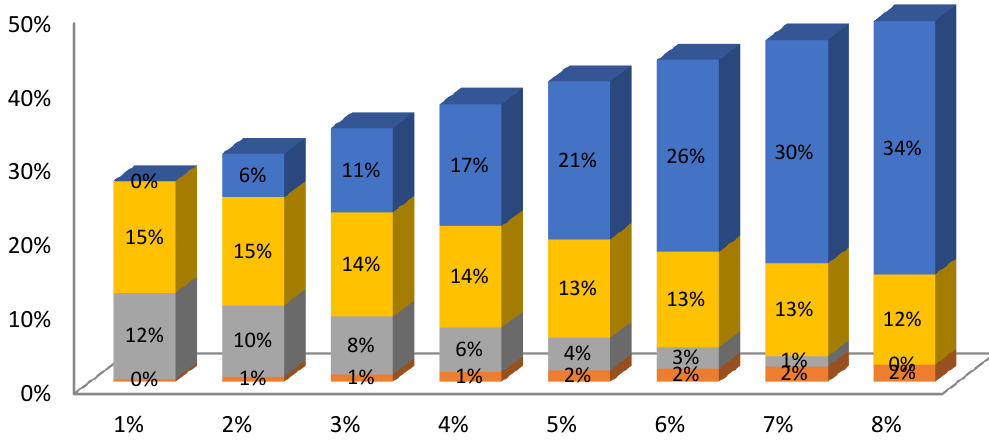
Figure 8. Break down of percentage of quality-related costs with respect to total cost (for moisture content of 50%).